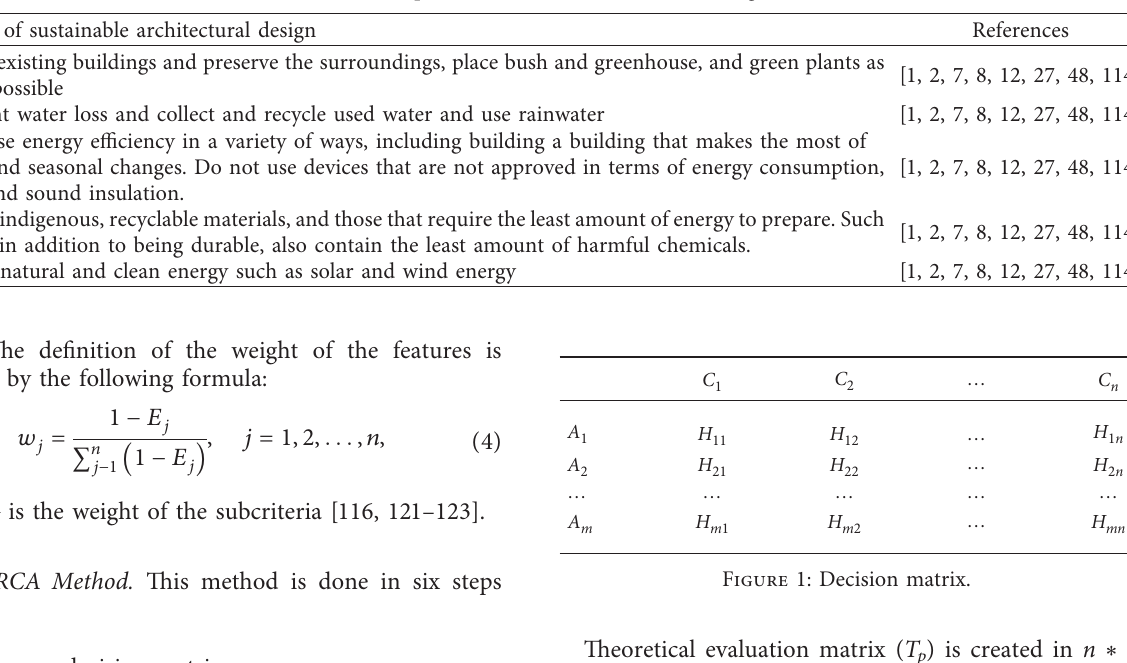
Table 2: Principles of sustainable architectural design.